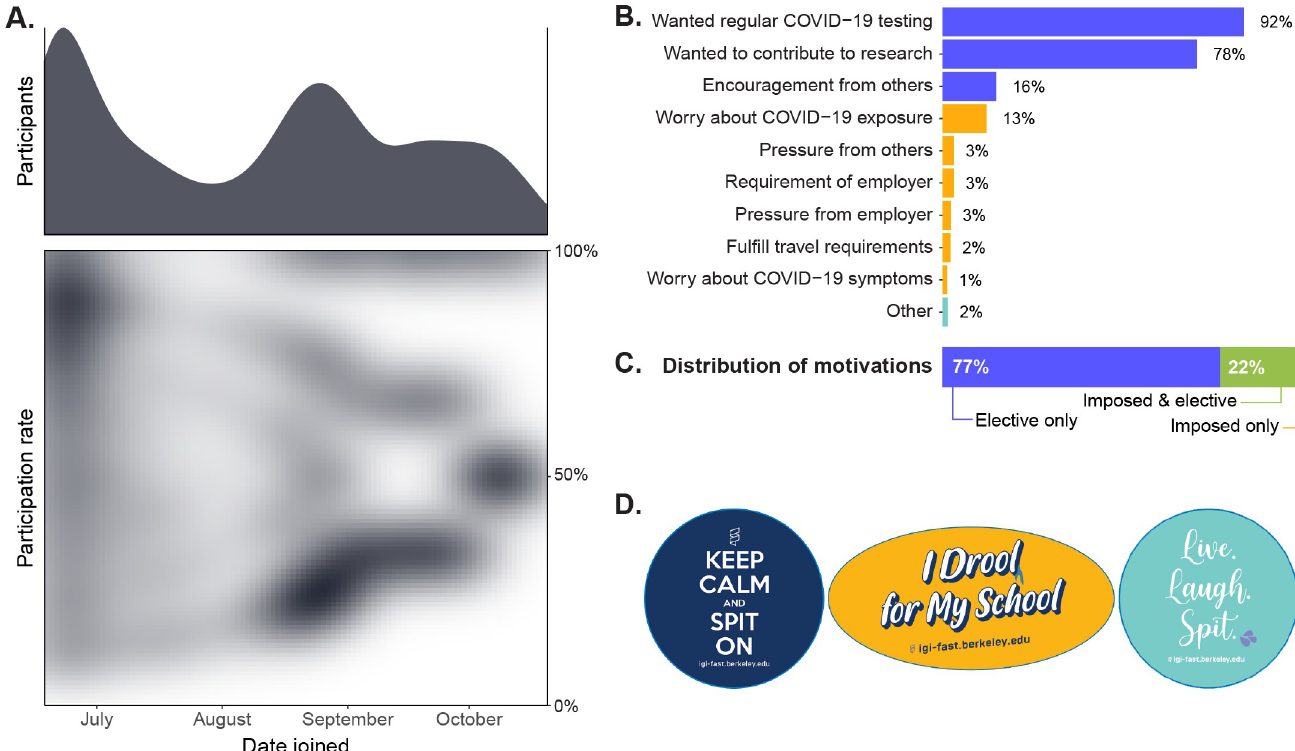
Fig 6. IGI FAST enrollment. (A) There were two waves of enrollment into the study–at the beginning of the study and again in the Fall when undergraduate students returned to the city for the beginning of the academic year. There was a wide variety of participation levels in the program. Here, participation rate represents the number of samples an individual gave divided by the number of possible appointments that individual could have made based on when they joined. The graphs here depict only active participants in the final cohort (n = 3,653). (B) The leading reasons for joining IGI FAST were elective (i.e., participants wanted regular viral testing, wanted to contribute to research, or had encouragement from friends/family/coworkers). 79% of the 865 respondents who completed this question reported more than one reason. (C) The majority (77%) of the total (n = 865) participants reported solely elective reasons for joining IGI FAST. Few (1%) reported imposed or "one-off" reasons (i.e., worry about COVID-19 exposure or symptoms, pressure from others, requirement or pressure from employer/boss/ supervisor, the fulfillment of travel requirements). One individual was excluded from this analysis because their response was unclassifiable. (D) Examples of stickers produced to facilitate the normalization of surveillance testing on campus through cultivating a sense of